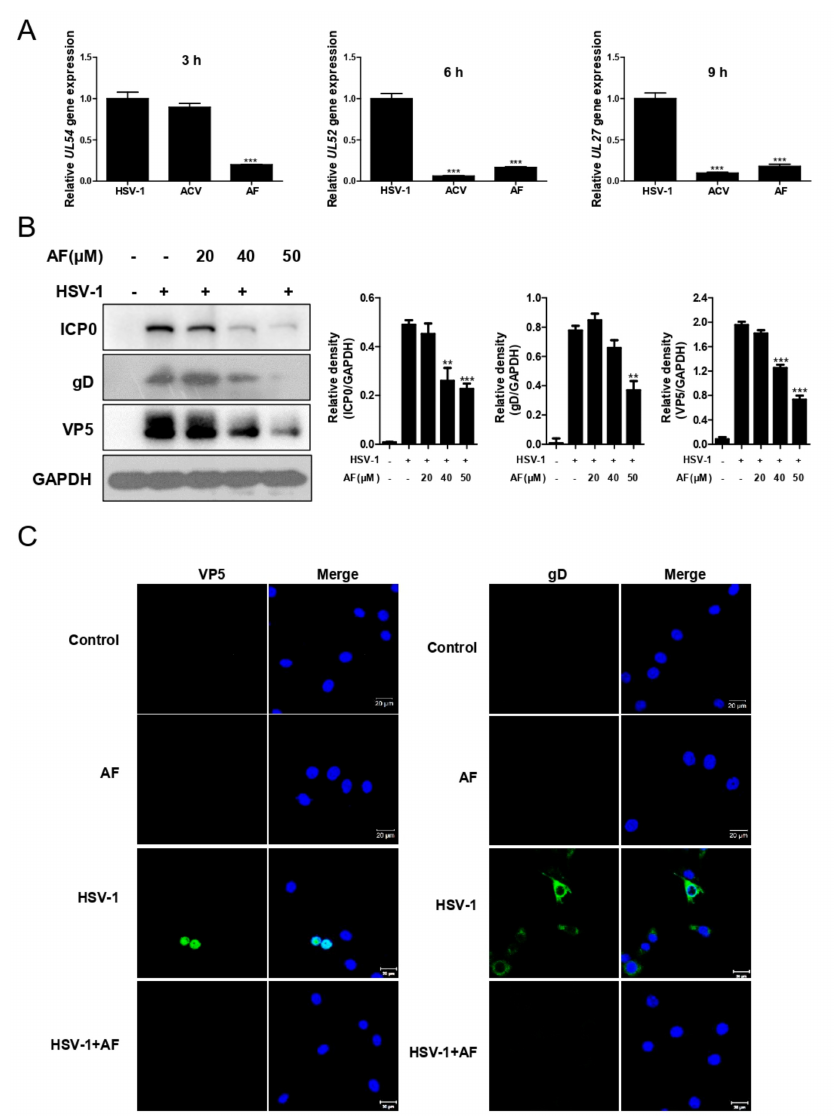
Figure 2. Amentoflavone inhibits viral gene and protein expression. ( A ) Vero cells were infected with HSV-1 (MOI = 1) in the presence of ACV (50 µ M), amentoflavone (50 µ M) or DMSO (control group). At di ff erent time points (3, 6, 9 h p.i.), total RNA samples were extracted and the mRNA expression levels of UL54 (immediate early gene), UL52 (early gene), and UL27 (late gene) were detected by qRT-PCR. The mRNA expression was normalized to 18s RNA. Data are mean ± SD ( n = 3). *** p < 0.001 versus HSV-1-treated group. ( B ) Amentoflavone inhibited viral protein expression. The cells were infected with HSV-1 for 3 h and the representative protein level of viral immediate early protein ICP0 was detected by Western Blot. For viral late protein gD and VP5, the cells were infected with HSV-1 for 9 h. Densitometric analysis for all western blot bands was shown. GAPDH served as a loading control. Data are mean ± SD ( n = 3). ** p < 0.01; *** p < 0.001 versus HSV-1-treated group. ( C ) The cells were infected with HSV-1 (MOI = 1) for 9 h in the presence of amentoflavone (50 µ M) or DMSO (control group), and were then fixed, stained with primary antibody against VP5 or gD (green). Nucleus was stained with DAPI (Blue). Images were recorded by a confocal